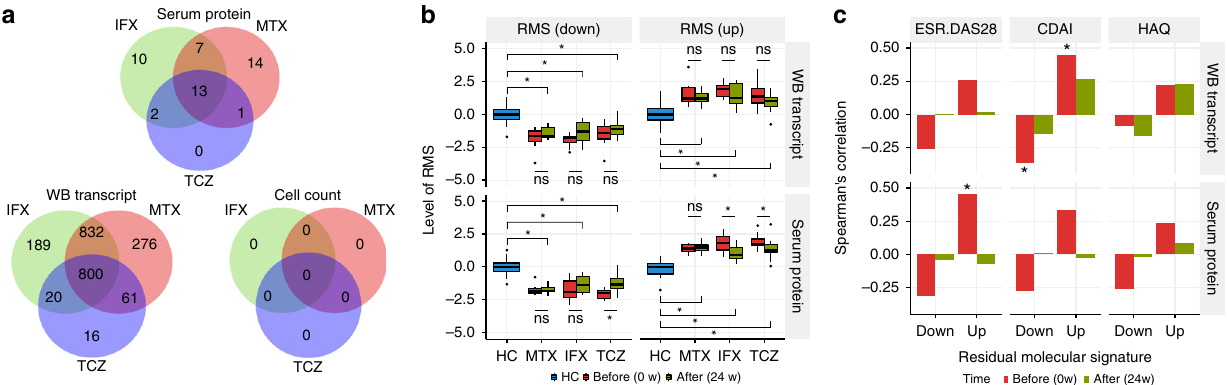
Fig. 4 Identi fi cation of residual molecular signatures. a Comparison of residual molecular signatures across treatments. b Meta-features of residual molecular signatures were differentially expressed in RA after drug treatment. Meta-features of residual molecular signatures were quanti fi ed by summarizing residual transcripts and proteins via the ssGSEA method. The levels of meta-features between RA and HC or before and after treatment were tested by Welch ’ s t -test or the paired t -test, respectively. The asterisk represents a p value <0.05. The upper, center, and lower line of the boxplot indicates 75%, 50%, and 25% quantile, respectively. The upper and lower whisker of the boxplot indicates 75% quantile + 1.5 * interquartile range (IQR) and 25% quantile − 1.5 * IQR. c Remission parameters associated with residual molecular signatures. The levels of meta-features for residual molecular signatures were associated with DAS28-ESR, CDAI, and HAQ-DI before and after treatment (Spearman ’ s correlation; n = 30; * p < 0.05)